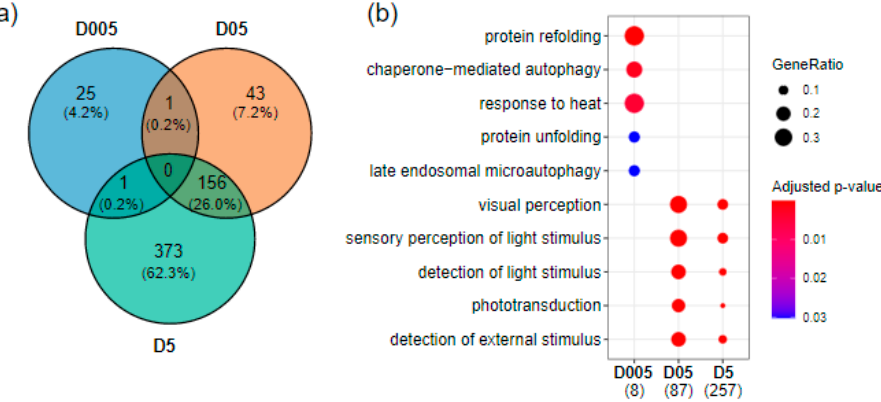
Figure 1. Transcriptomics effects of radiation exposure on zebrafish telencephalon. ( a ) Venn dia- gram of differentially expressed genes at the three dose rates (|fold change| ≥ 1.5 and adjusted p -value < 0.05. ( b ) GO enrichment of biological processes using human orthologues showing the top enriched pathways at D005 (0.05 mGy/h), D05 (0.5 mGy/h) and D5 (5 mGy/h). The numbers in brack- ets correspond to the number of genes present in the enriched GO terms. The dot size corresponds to the fraction of genes in a given GO term compared to all DEG (GeneRatio).